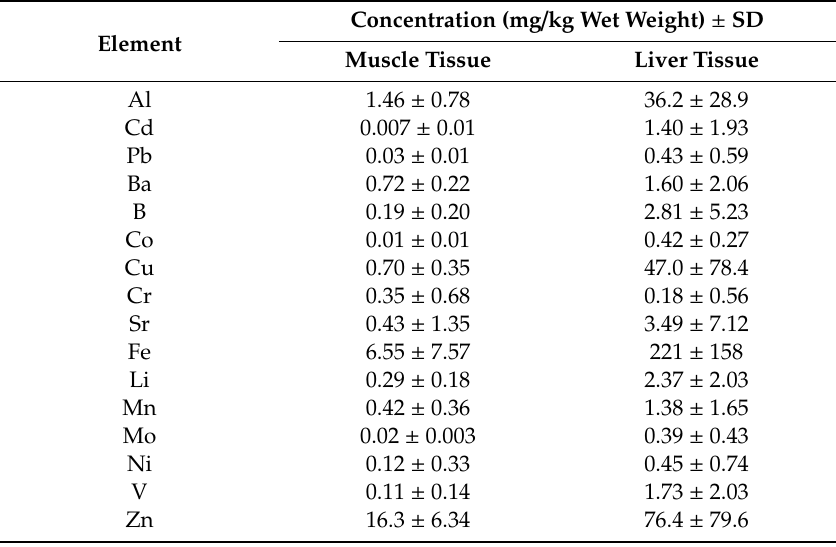
Table 3. Mean concentration (mg / kg wet weight) and standards deviations (SD) for the analyzed metals according to the tissue